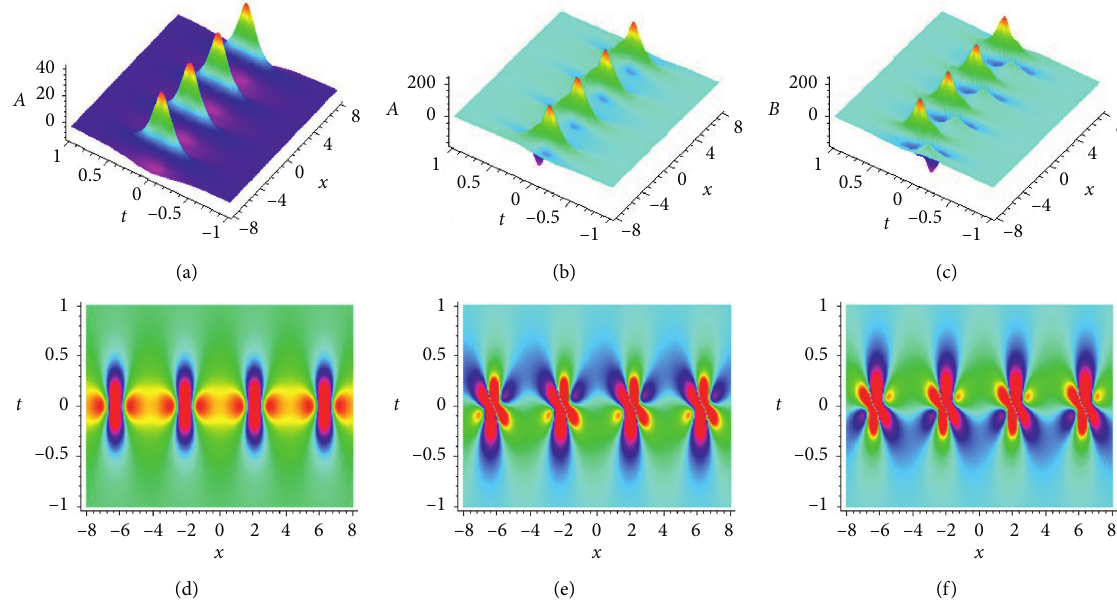
Figure 4: The x -breather solution of equation (25) with (a) b (a)–(c),